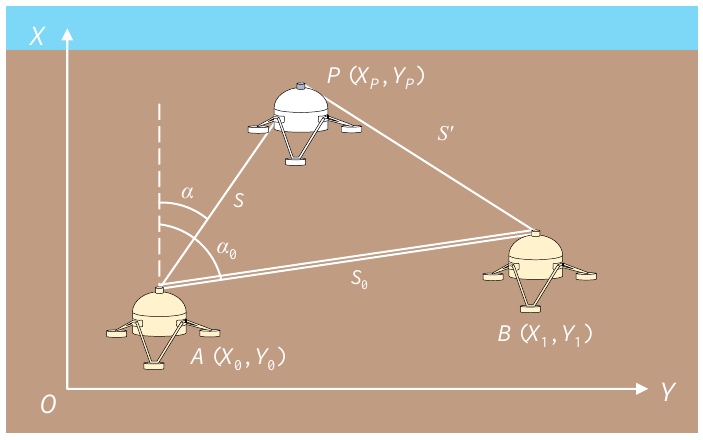
Figure 6. The geometric relations of control points in the equilateral triangle unit network. The yellowish points are known points.